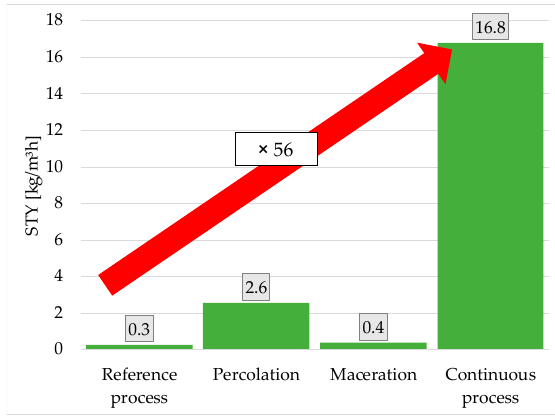
Figure 22. Comparison of the space-time yield for the examined process alternatives.